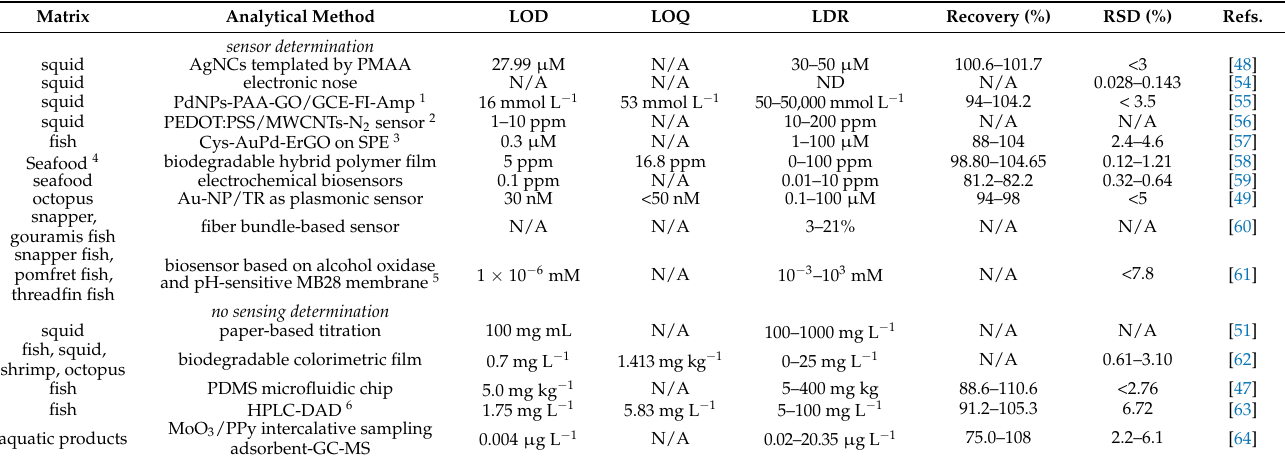
Table 3. Analytical performance of sensing and no-sensing determinations applied to fish matrix. The term “N/A” means the information is absent in the